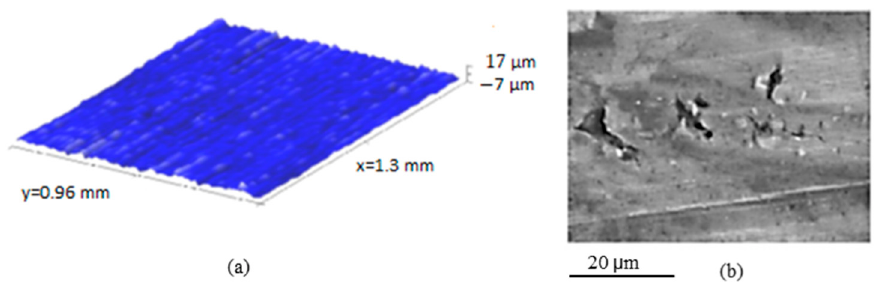
Figure 2. ( a ) Image of the surface texture of the uncorroded alloy, where x axis represents the rolling direction, ( b ) scanning electron microscopy (SEM) image showing the rolling microcracks.